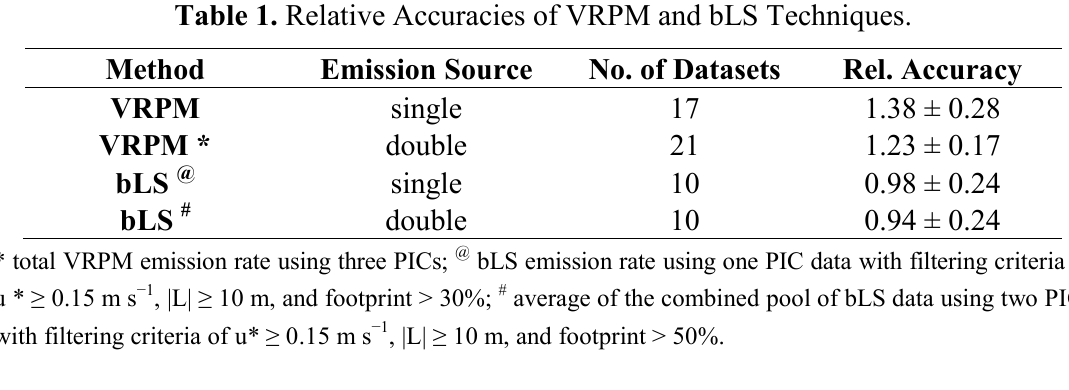
/Q from double sources vs. number of VRPM